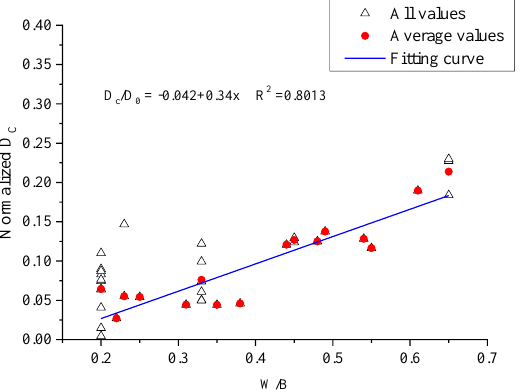
Figure 10. Chloride diffusion coefficient of concrete after different W/B.